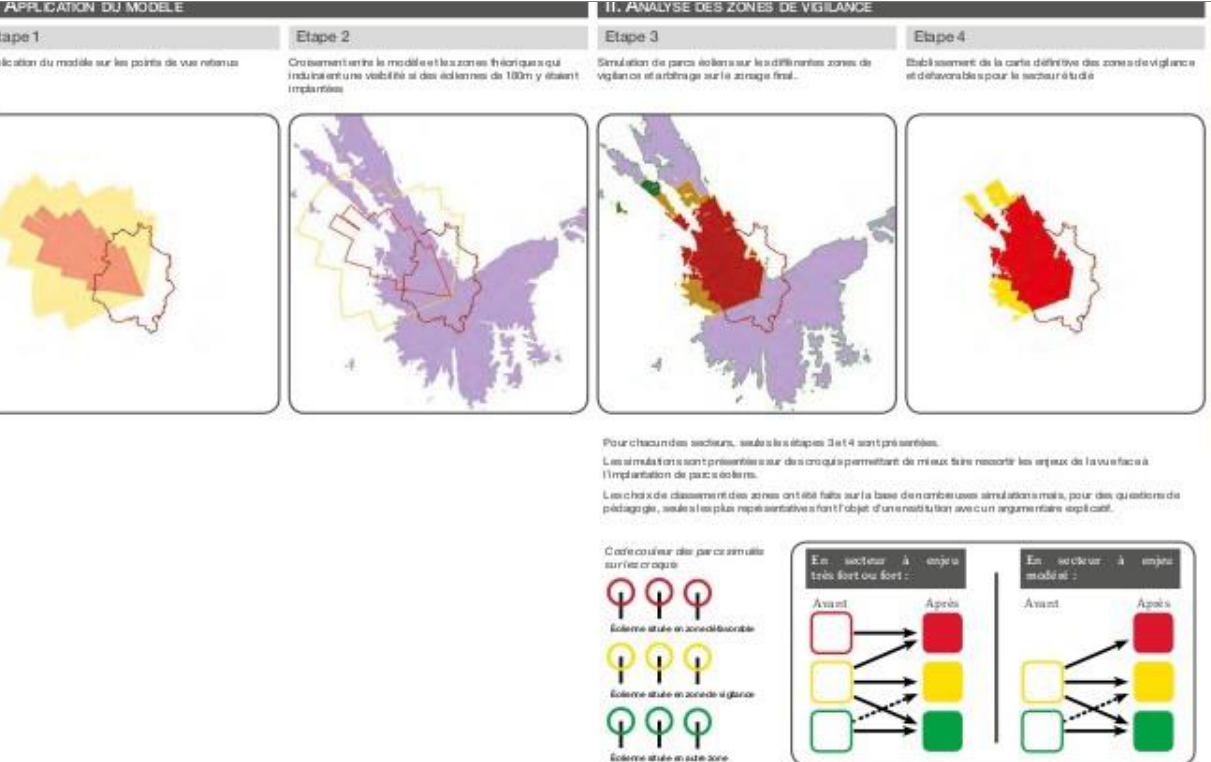
Figure 15. Zoning of wind turbines in the Vézelay landscape (France) based on angle of view and distance of the turbines: unfavorable (red), caution (yellow), and other zones (green) (Source: [84]). The impact of these technologies may vary depending on their visibility, number, and distance from the property. Kloos et al. suggested the importance of maintaining the overall quality of the landscape by studying the interrelations between wind elements and surroundings [86]. The visibility of wind turbines should be assessed according to the following criteria: (i) technical dominance of the landscape image; (ii) visual dominance of the turbines; and (iii) distortion of the landscape scale. Noisy of wind turbines is not reported as a problem, probably because of the distance from inhabited